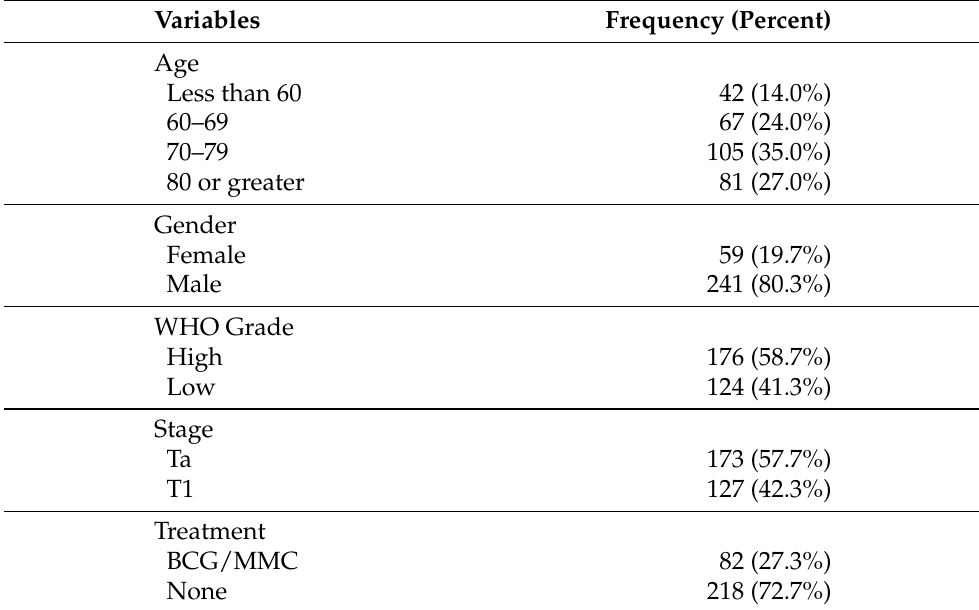
Table 1. Summary of clinical and pathological